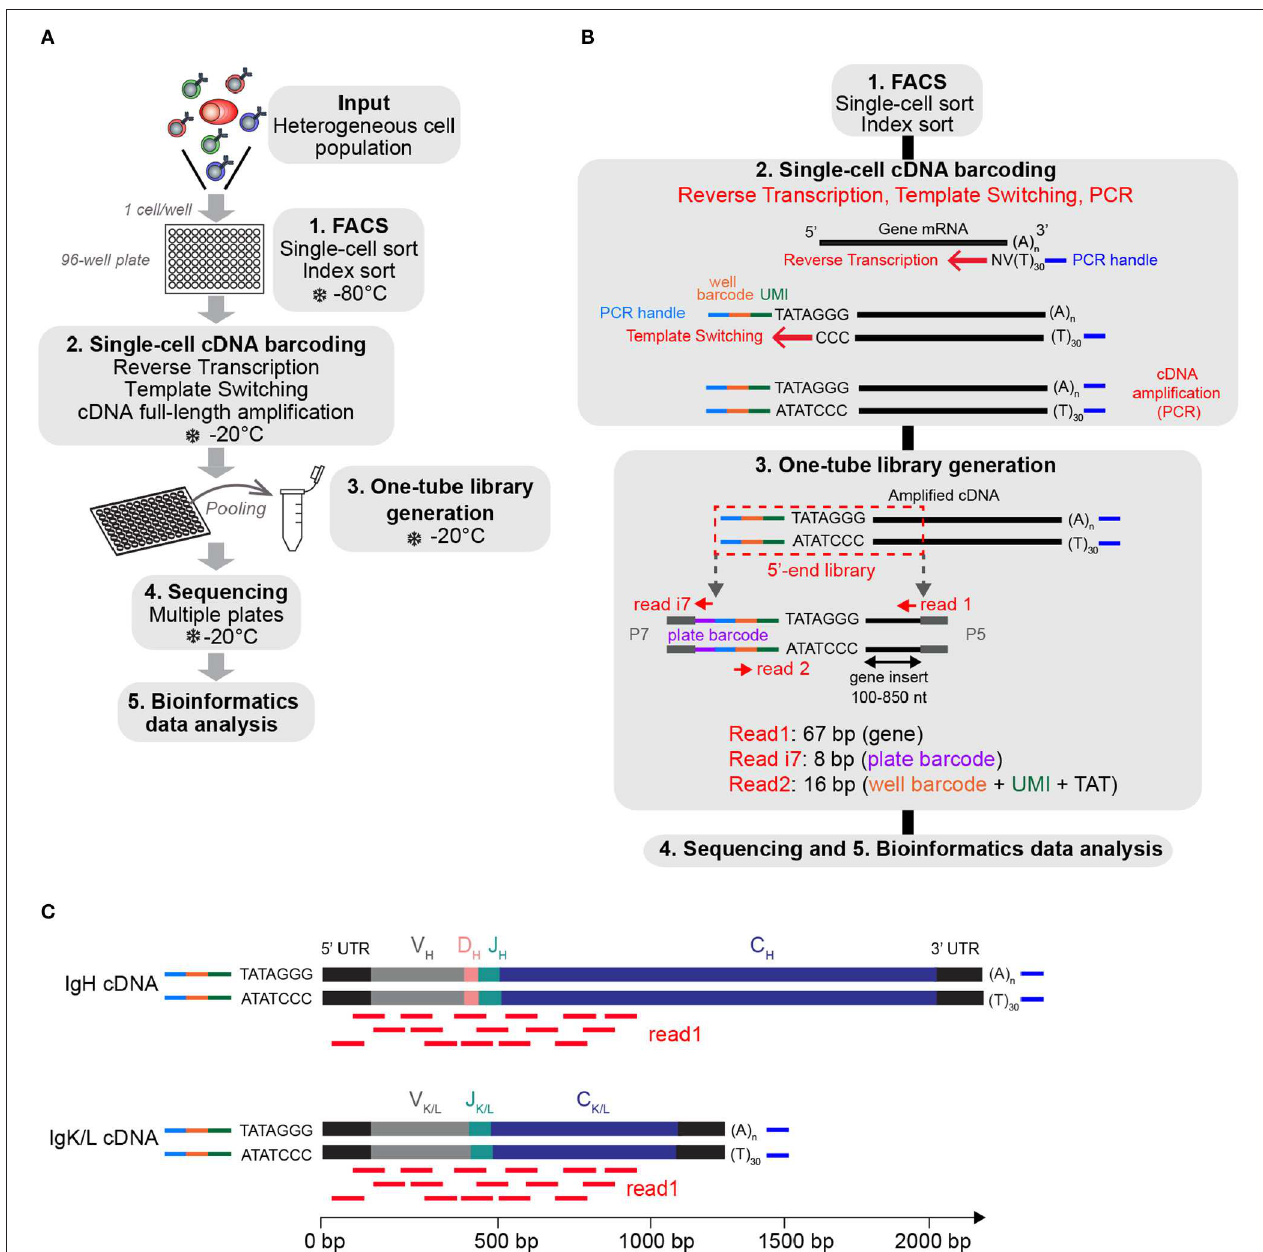
FIGURE 1 | Overview of the FB5P-seq experimental workflow. (A) Major experimental steps of the FB5P-seq workflow. (B) Schematic overview of the molecular designs and the reactions in the FB5P-seq workflow. (C) Schematic illustration of the mapping of the Read1 sequences (in red) on IGH and IGK or IGL amplified cDNA, enabling the in silico reconstruction of paired variable BCR